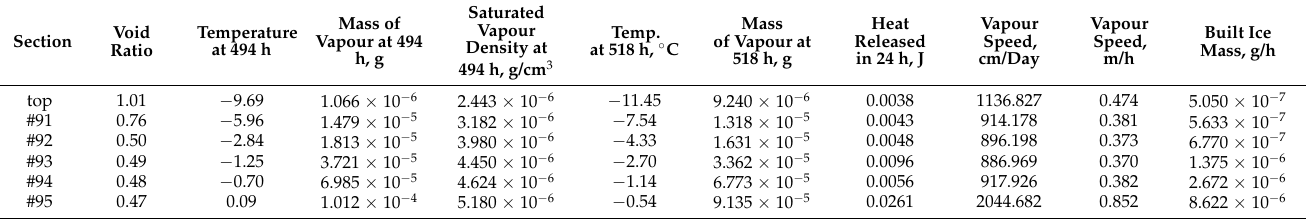
Table A3. Calculation of soil parameters for the 24 h time interval for column